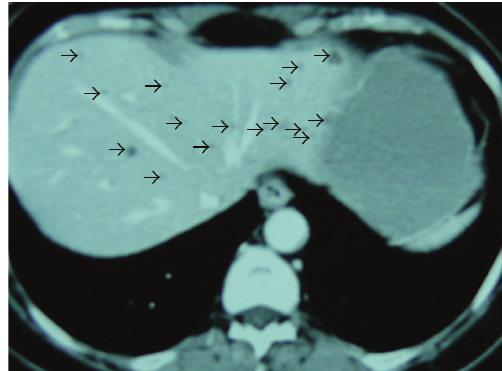
Figure 2: Contrast-enhanced CT revealed multiple, scattered, small, hypodense nodular lesions in liver (black